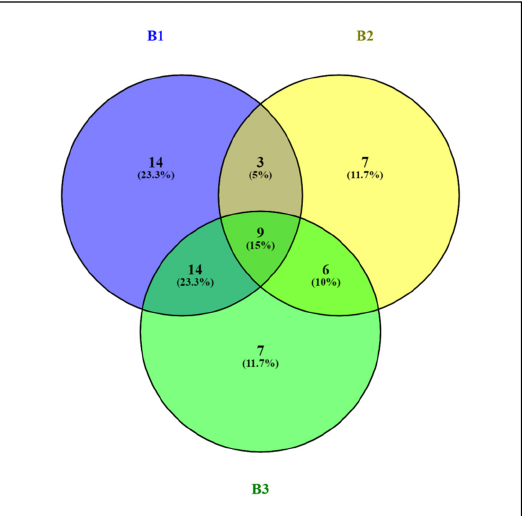
Figure 6. Venn diagram showing the logical relation between OTU 16S rRNA genes of the bacterial community of the Actinobacteriota phylum in samples of alluvial brown soil (B1), leaf litter (B2) and soil from epiphyte baskets (B3) collected in the Pu Hoat Nature Reserve.